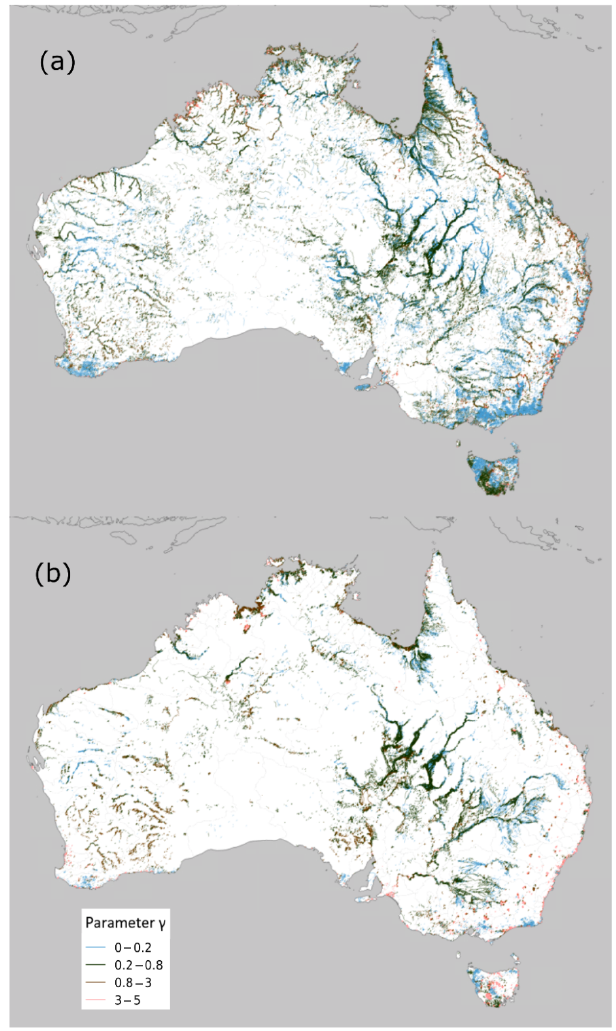
Figure 8. River morphology classification γ parameter values for medium (a) and large (b) rivers for Australia.